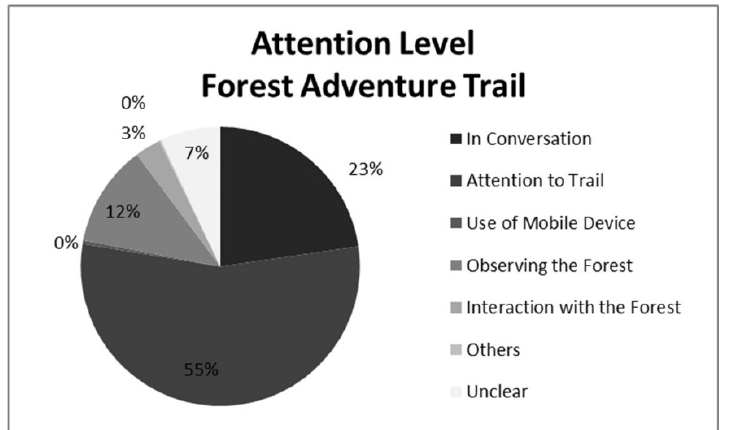
Figure 6. Percentages of attention at the monitoring site “M-Kam/M-Cam” at the Forest Adventure Trail, Freising, Bavaria, Germany, averaged for the period from 19 December 2014, until 6 January 2015; 1804 passersby were counted during this monitoring period.